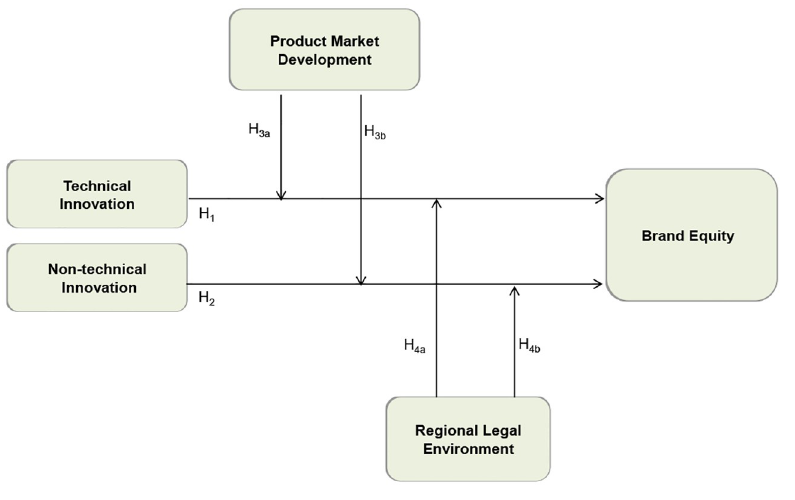
Fig 1. The conceptual